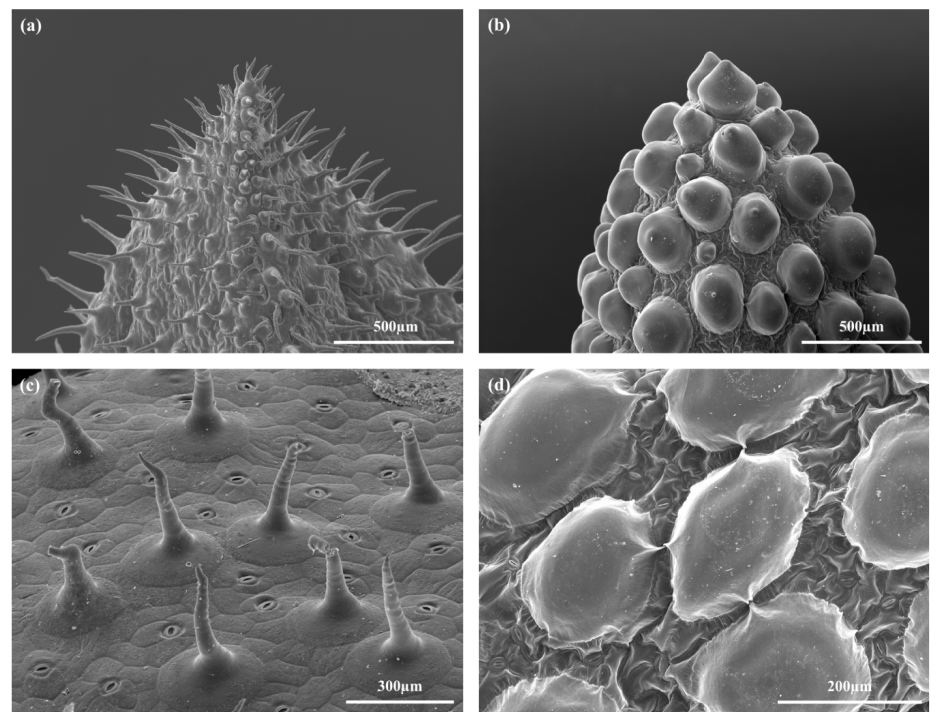
Figure 4. Scanning electron microscope images of leaf tips ( a , b ) and epidermal bladder cells ( c , d ) of D . ecklonis ( a and c) and D . cooperi ( b and d ).